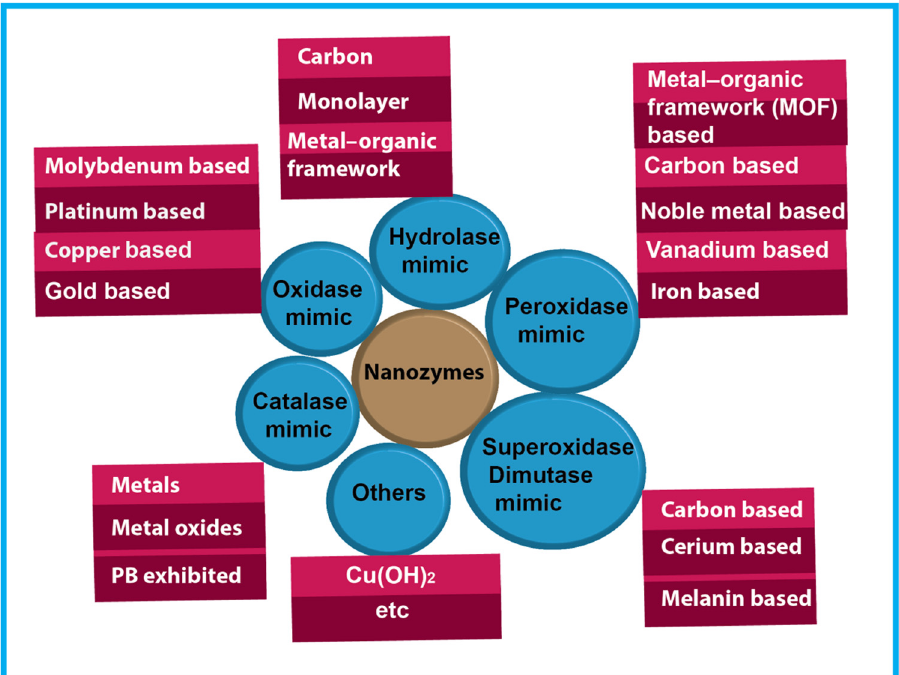
Figure 4: Types of nanozymes.